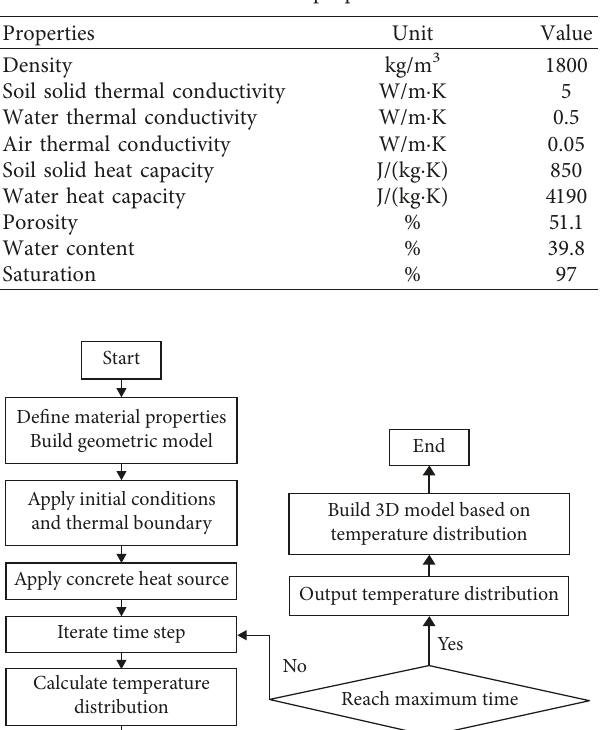
Table 1: Soil properties.